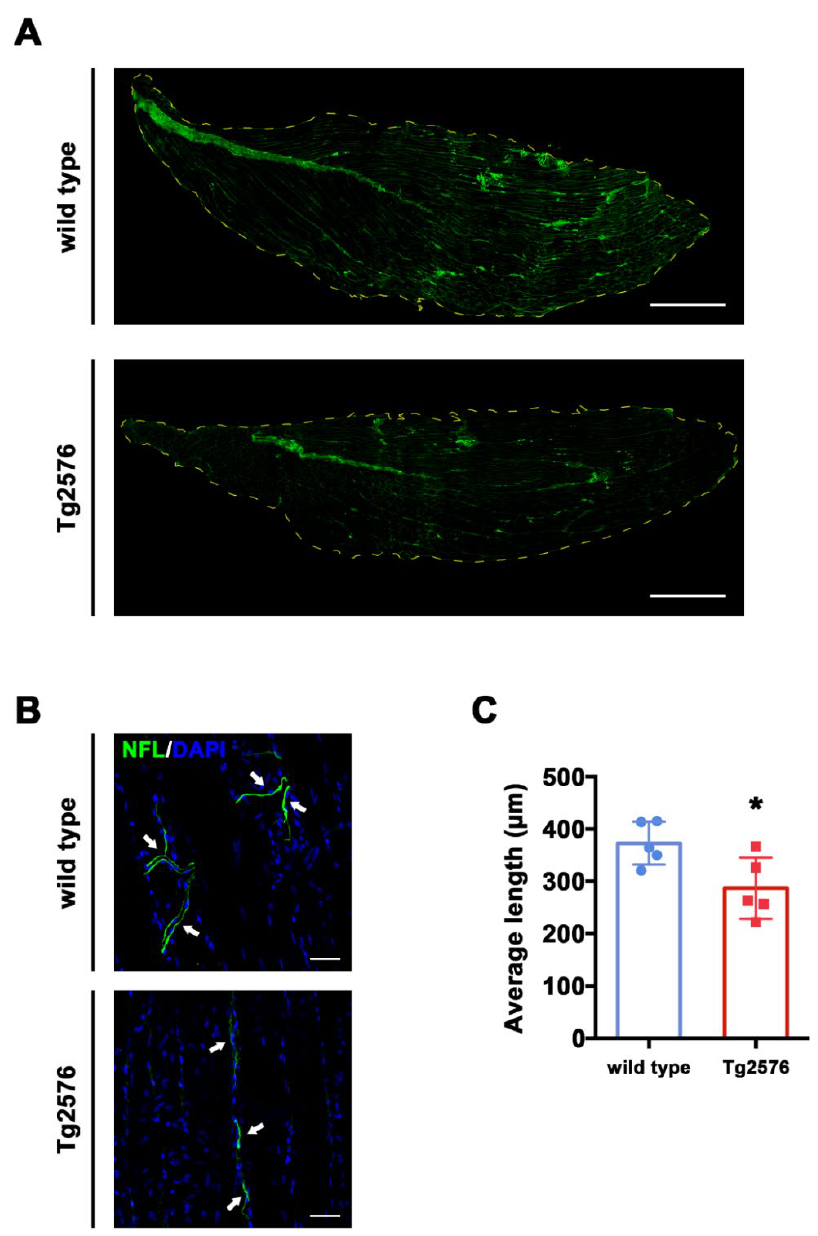
Figure 1. Tg2576 mice display reduced neuritic length in TA. ( A ) Representative images of whole longitudinal section of TA muscle of wild type and Tg2576 mice. Green stain corresponds to NFL positive area. Dotted yellow line corresponds to TA edges. Scale bar = 1 mm ( B ) Representative images of NFL-stained TA sections of Tg2576 and wild type mice. Sections were counterstained with DAPI in order to detect cell nuclei. White arrows point to neurofilaments. Scale bar = 50 µm. ( C ) Histogram reporting average axonal length/ROI ± SEM from NFL-stained TA slices of Tg2576 and wild type mice ( n = 5 mice per genotype). Unpaired t test was used for comparison (* = p < 0.05).